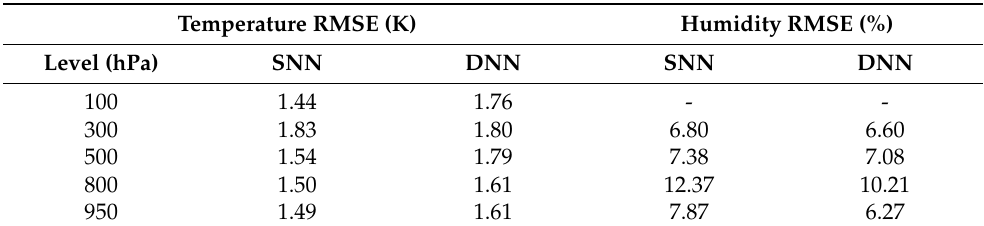
Figure 12. The DNN-based and the SNN-based retrieval RMSEs using MWHTS simulated brightness temperatures. Table 7. Summary of the DNN-based and the SNN-based retrieval RMSEs using MWHTS simulated brightness temperatures.